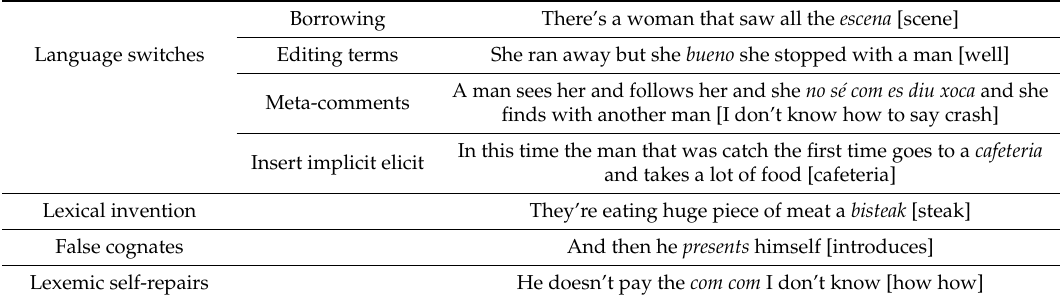
Table 1. Classification of lexemic Crosslinguistic Influence (CLI) and examples from the